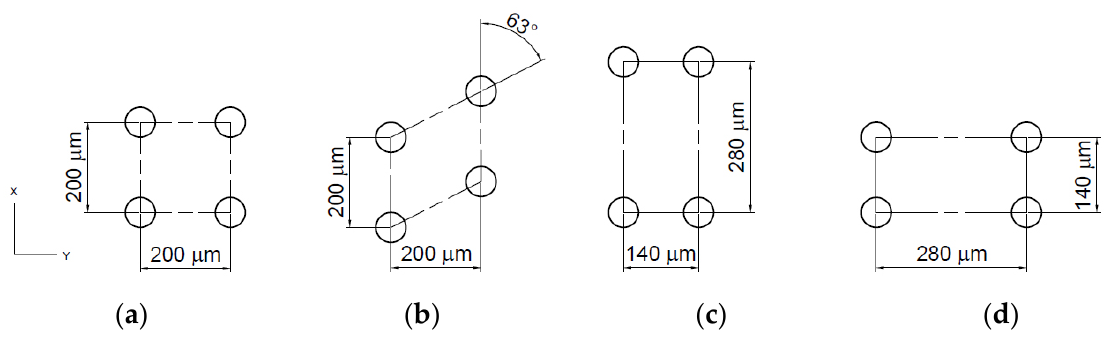
liner axis array ( c ), shortening along the liner axis array ( d ), after [104].